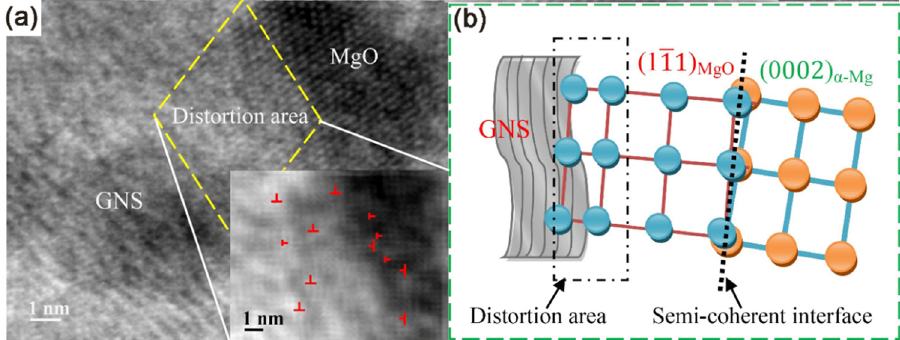
Figure 6: ( a ) High - magni fi cation image of the distortion area. ( b ) Schematic illustration of the interface of MgO/ α - Mg and GNS/MgO [ 179 ]